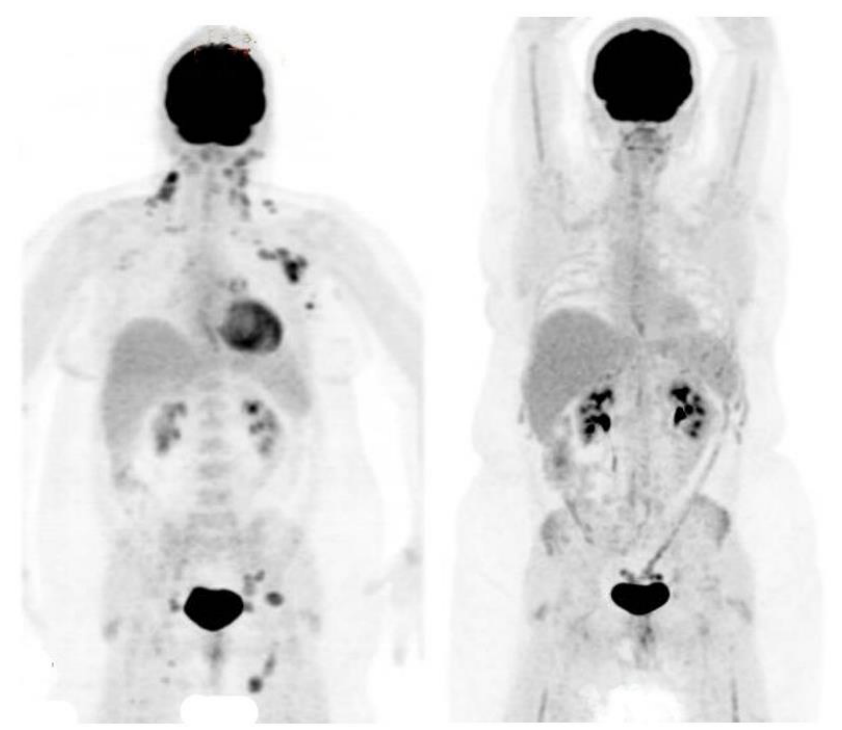
Figure 1. PET scans before and after wide-field radiation therapy.